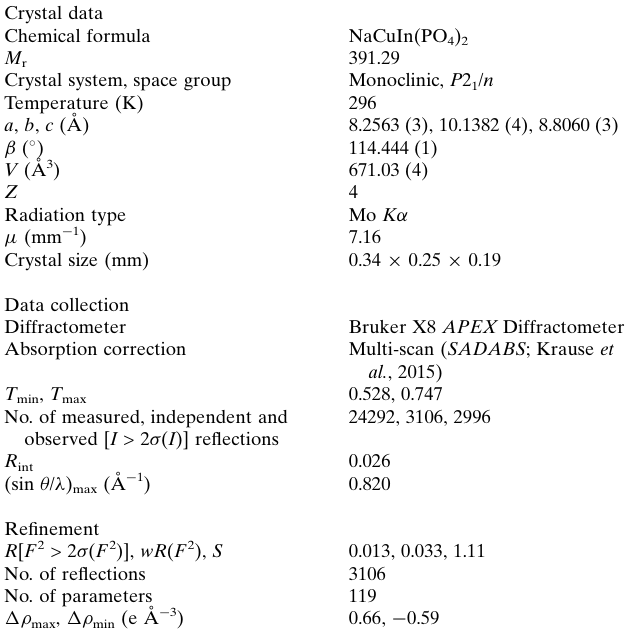
Crystal data Chemical